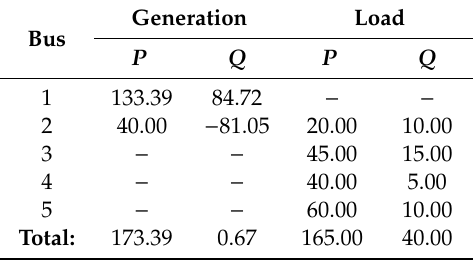
Table A13. Results of the mixed AC / DC PF calculations in Case 4. AC bus data.